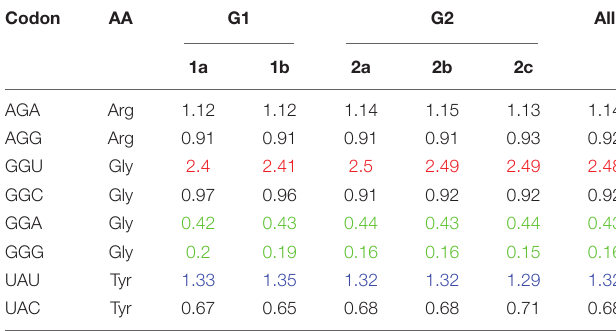
TABLE 2 | RSCU values of the whole coding sequence in 56 PEDV